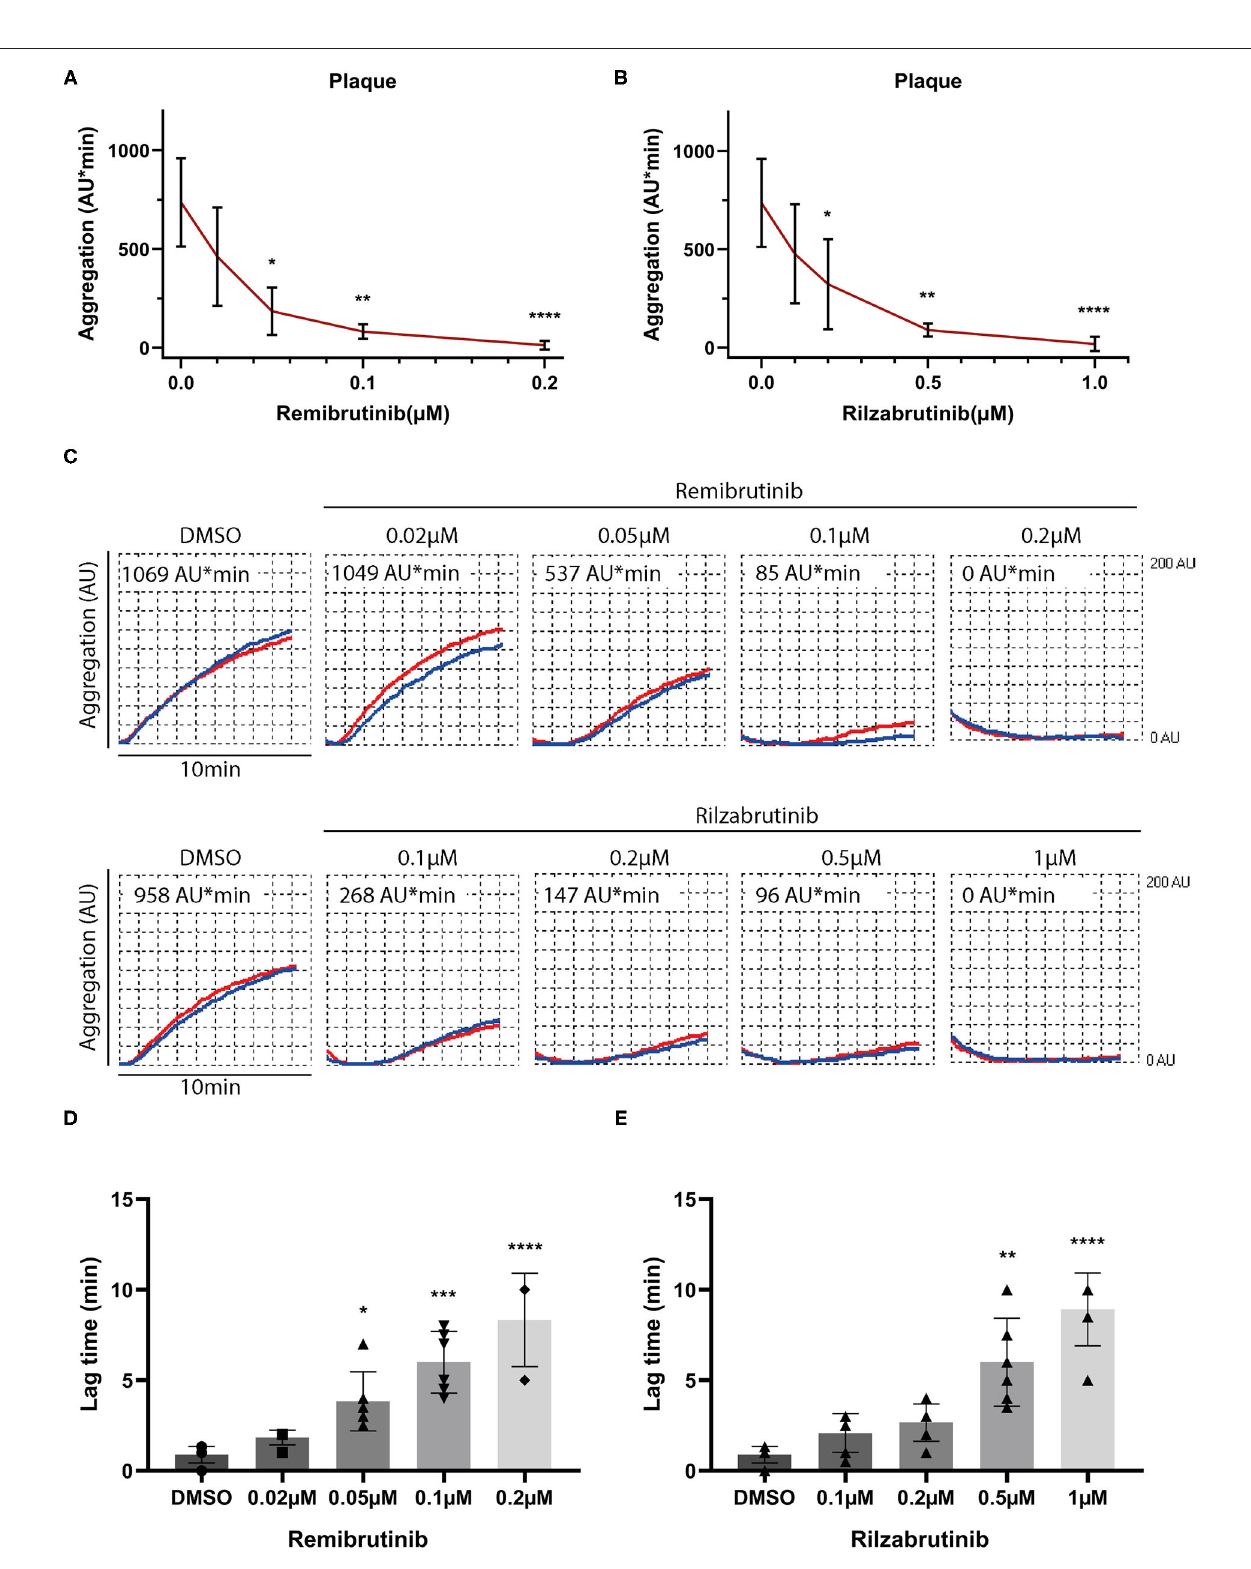
FIGURE 1 | Effects of increasing concentrations of remibrutinib and rilzabrutinib on platelet aggregation in blood stimulated by plaque homogenate. Hirudin anticoagulated blood was preincubated for 1h at 37 ◦ C with solvent control (DMSO, 0.1%), or increasing concentrations of remibrutinib (A,C,D) or rilzabrutinib